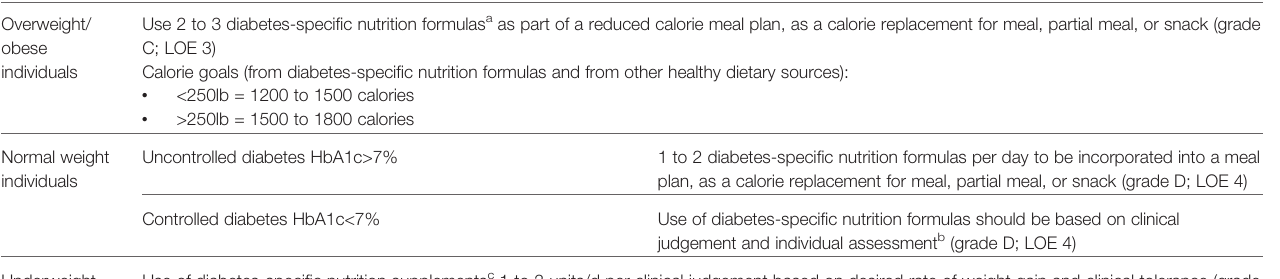
TABLE 2 | Evidence-Based Algorithm for the use of Diabetes-Speci fi c Nutrition Formulas in Prediabetes, Type 1 Diabetes and Type 2 Diabetes. Overweight/ obese